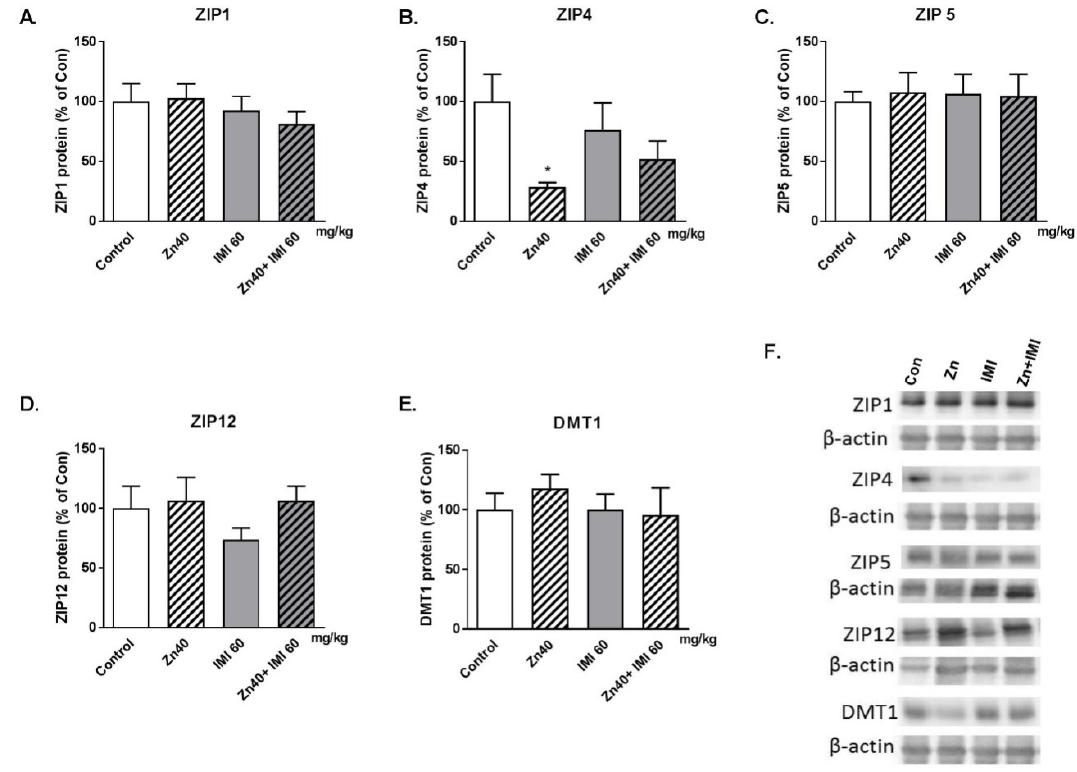
Figure 5. Western blot analysis of the e ff ect of Zn (40 mg Zn / kg) + IMI (60 mg / kg), and NaCl (control) administered p.o. on the protein levels of zinc transporters: ( A ) ZIP1, ( B ) ZIP4, ( C ) ZIP5, ( D ) ZIP12, and ( E ) DMT1 in the mouse small intestine. Representative western blots ( F ). Results are expressed as mean ± S.E.M (n = 5–7 per group). * p < 0.05 vs. control group (two-way ANOVA followed by Tukey post-hoc test).